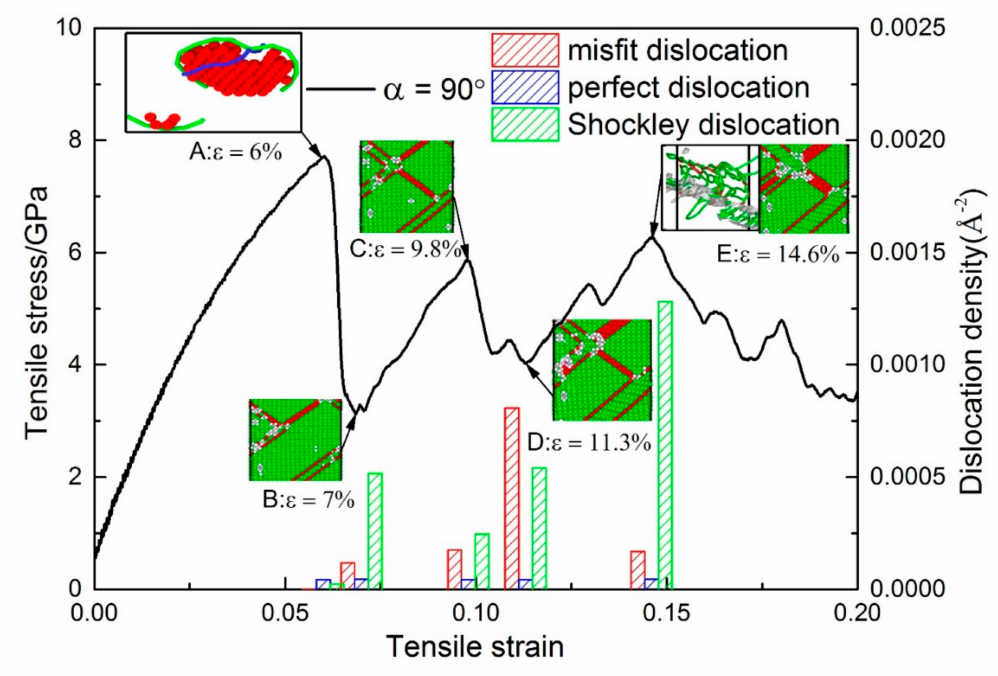
Figure 12. Plots for both the stress-strain curve and the dislocation density for the models while α = 90 ◦ . Snapshots ( A ) and ( E ): DXA at ε = 6% and 14.6%, respectively. Snapshots ( B ), ( C ), ( D ), and ( E ): CNA at ε = 7%, 9.8%, 11.3%, and 14.6%,